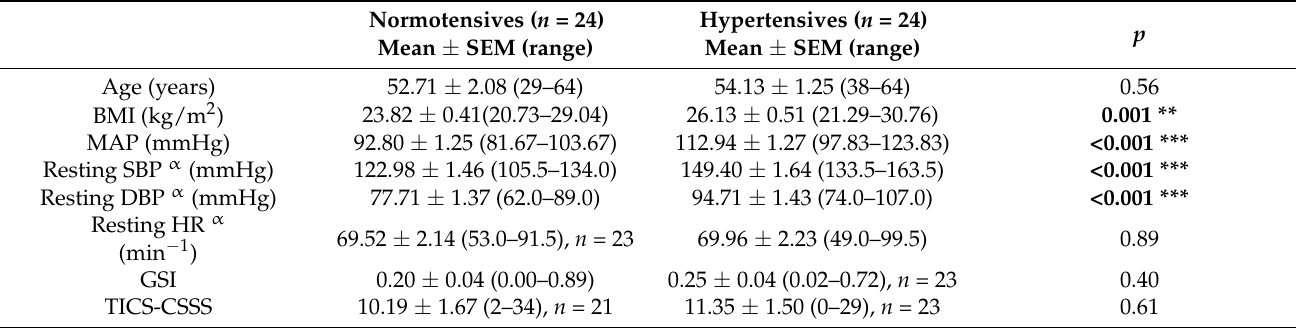
Table 1. Characteristics of study